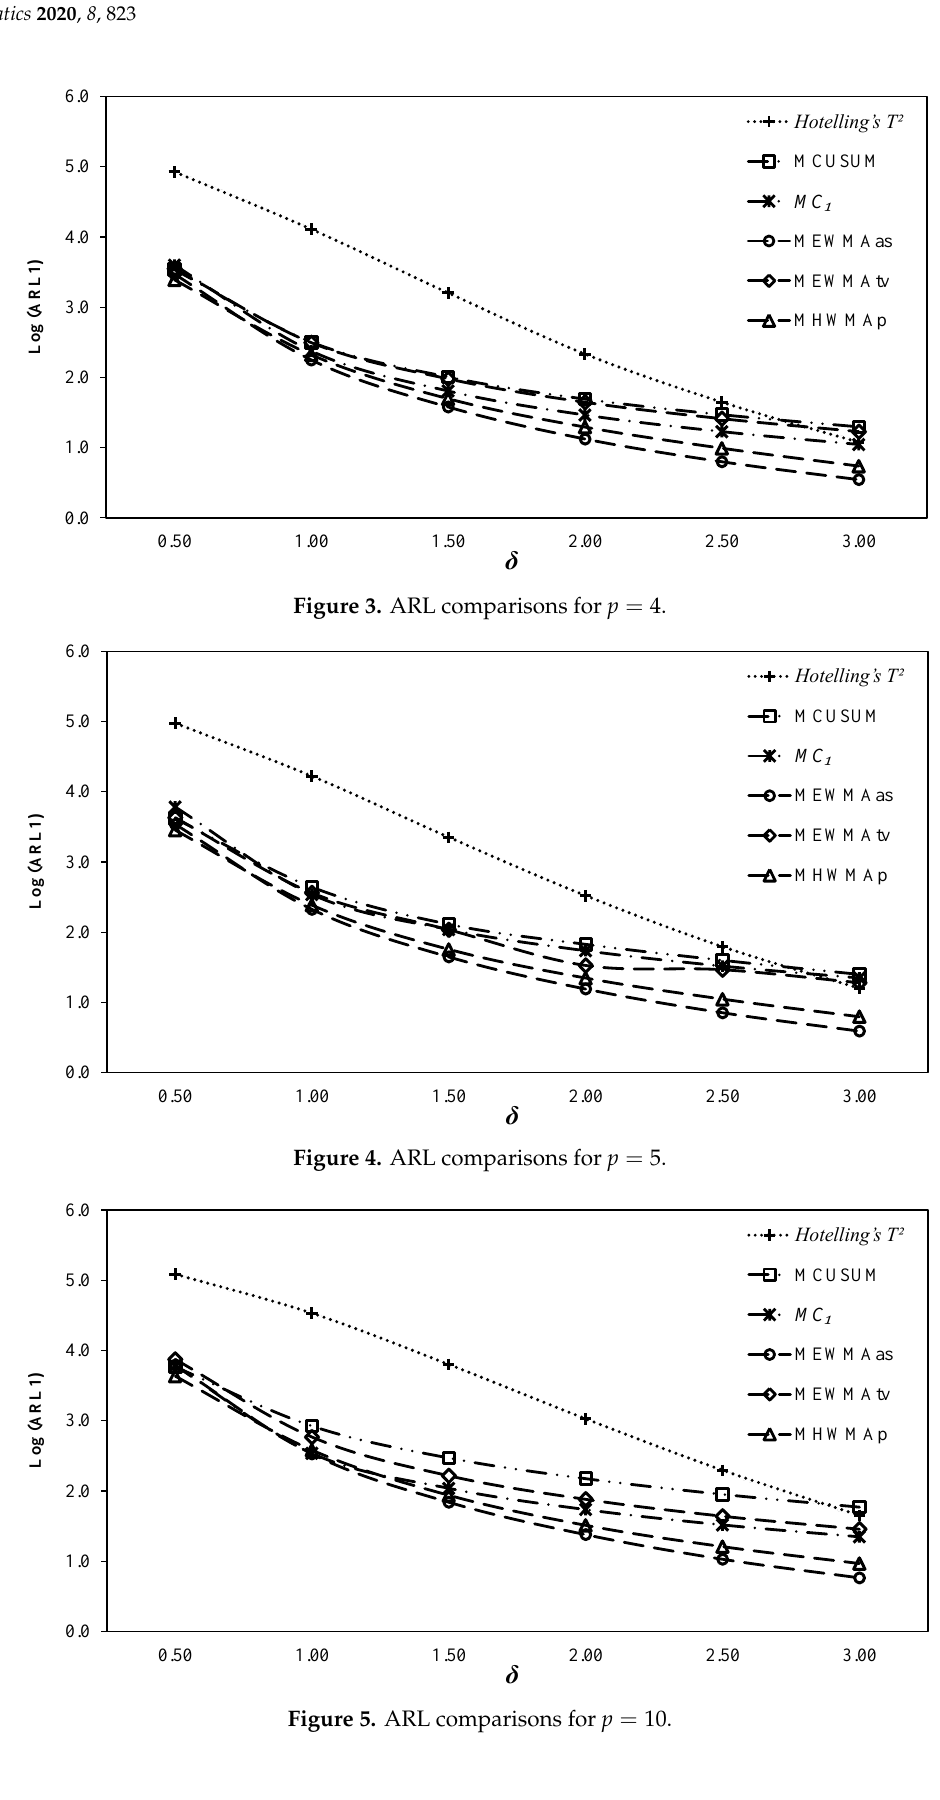
Figure 5. ARL comparisons for 𝑝 = 10 .